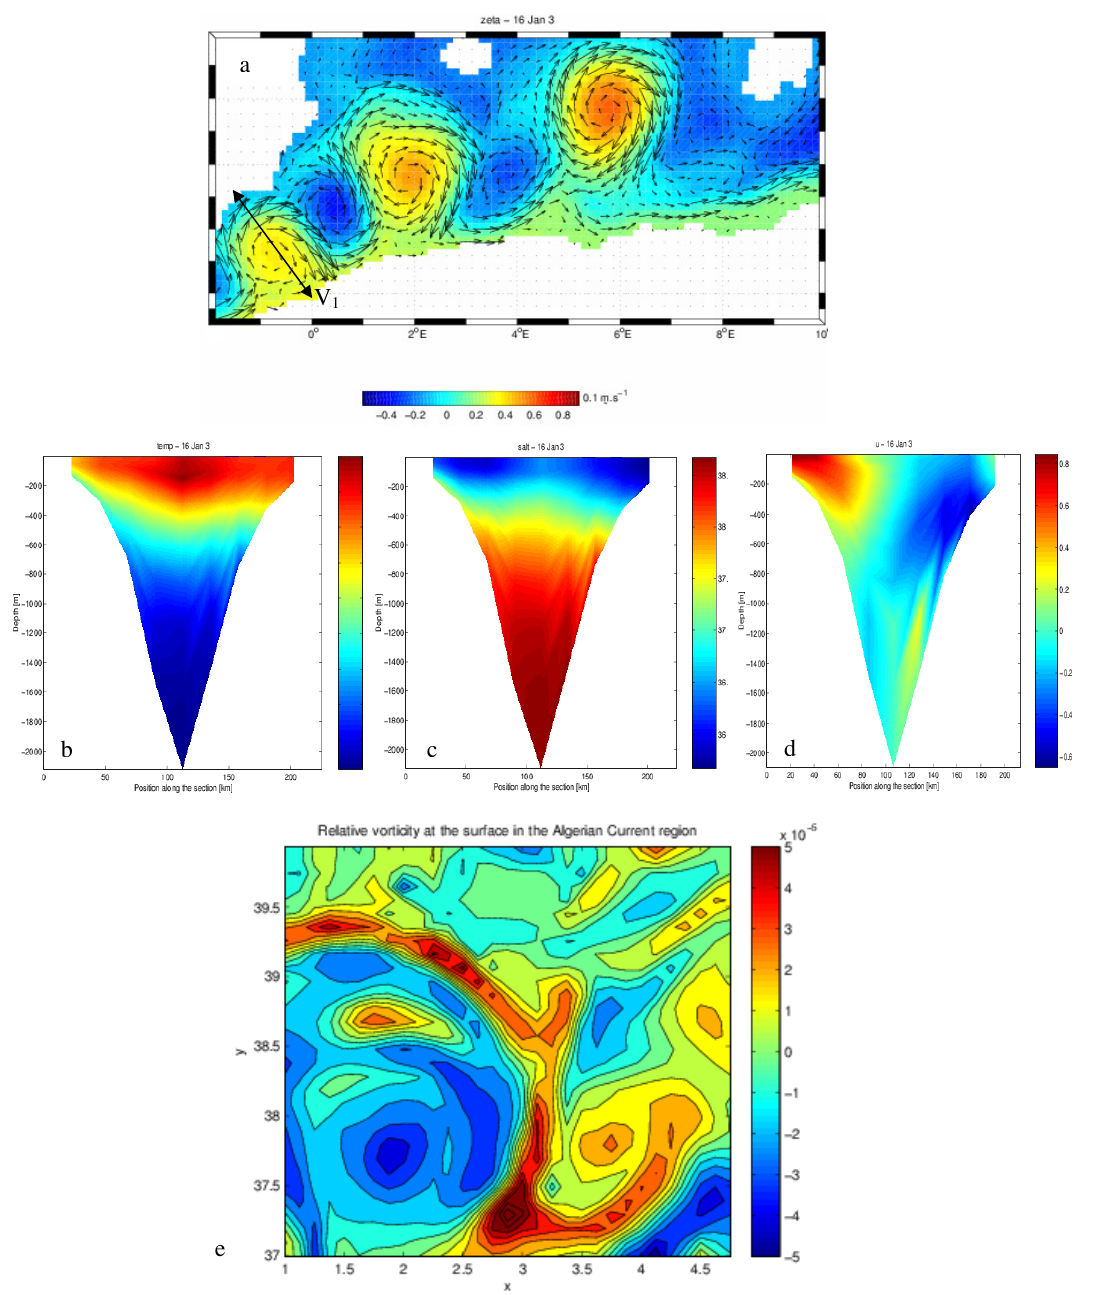
Fig. 2. (a) Simulated surface currents superimposed on the surface elevation in a subdomain of the western Mediterranean Basin. Vertical section of (b) temperature, (c) salinity and (d) perpendicular velocity through vortex V 1 . (e) Relative vorticity in a subdomain of the western Mediterranean basin.